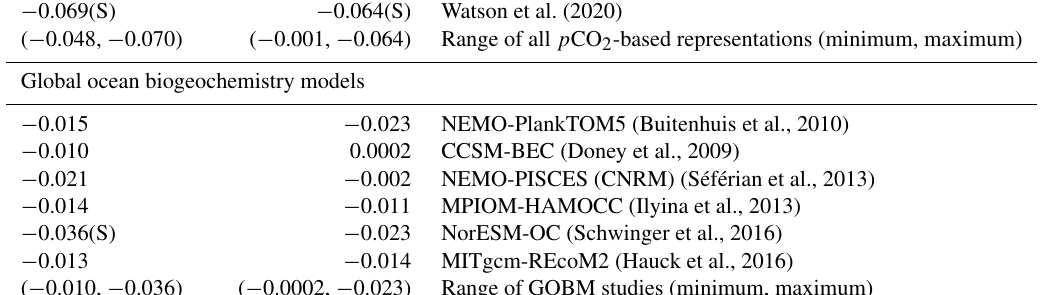
a The symbol “(S)” indicates that the calculated trend is statistically significant (at the 95% confidence interval). b The uncertainty of the fitted trend from the GCL estimates is reported as 1 standard deviation of the ordinary least squares (OLS)-fitted slope (Montgomery et al.,